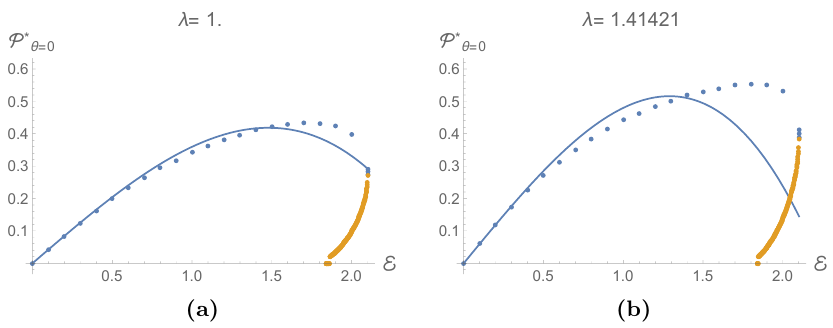
Figure 21. Timelike static orbits of charged particles for two values of (cid:21) = q=m as a function of the electric